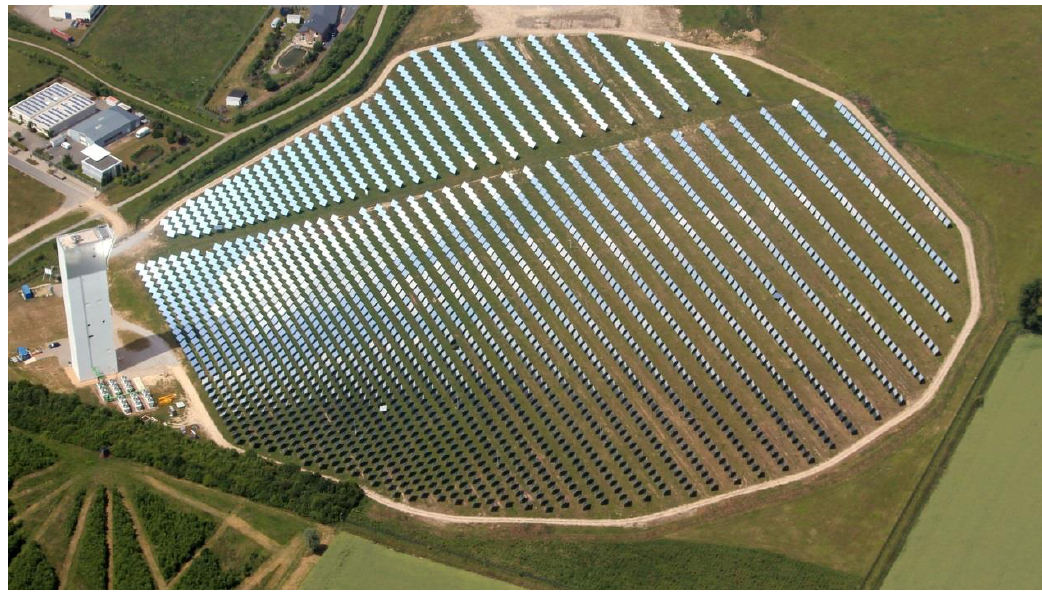
Figure 2. Jülich solar power tower (Germany).